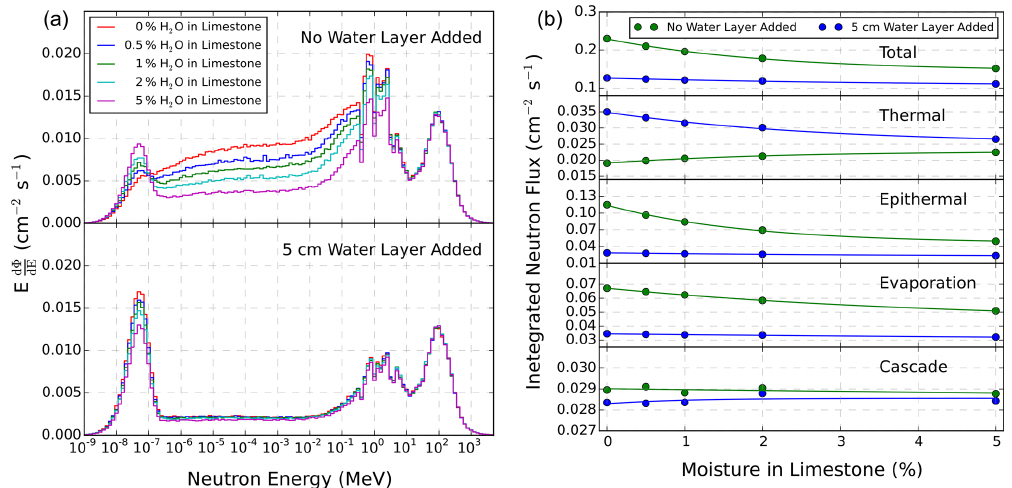
Figure 10. (a) Simulated neutron flux spectra with different moisture content in limestone (0%, 0.5%, 1%, 2%, and 5%) without a water layer on the ground (top) and with a 5cm water layer on the ground (corresponding to a snow height of about 20cm) (bottom). (b) Neutron flux integrated over the whole energy range (“total”) or integrated over the four considered neutron energy ranges (thermal: E < 0 . 4eV; epithermal: 0.4eV ≤ E < 100keV; evaporation: 100keV ≤ E < 20MeV; cascade: E ≥ 20MeV); solid lines represent fits of the data to ae − bx + c